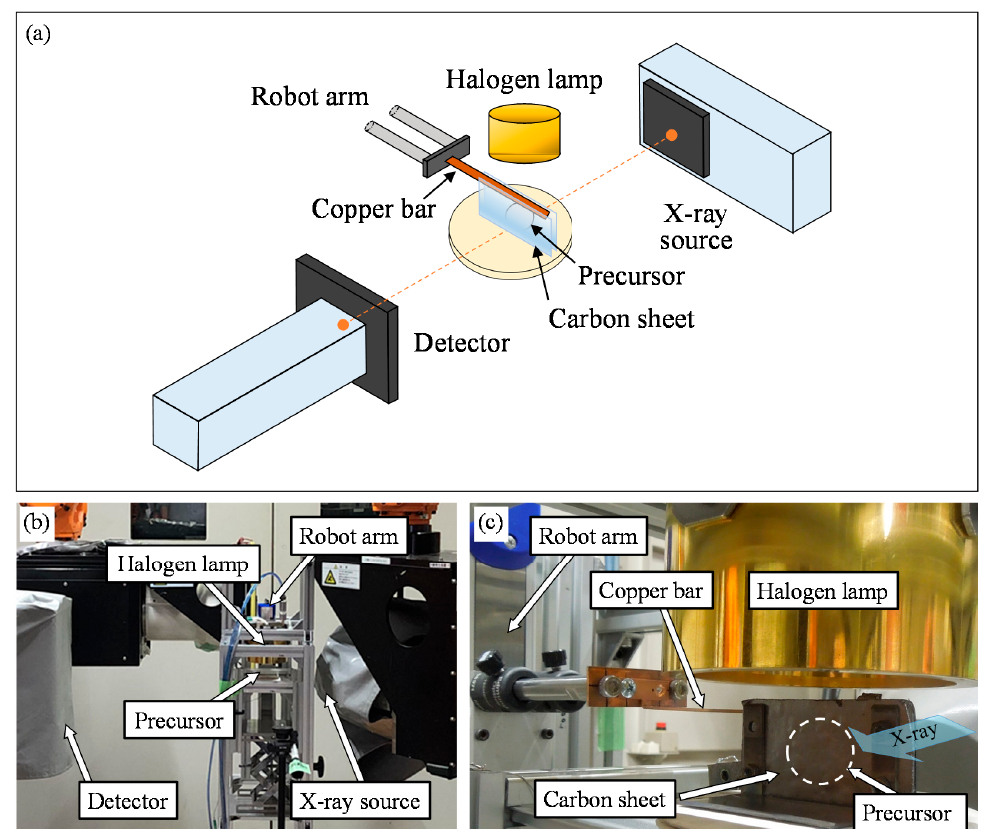
Figure 2. X-ray transmission system for observing pores during press forming of aluminum foam immediately after foaming. ( a ) Image of setup, ( b ) Photograph of equipment and ( c ) enlarged photograph around precursor.